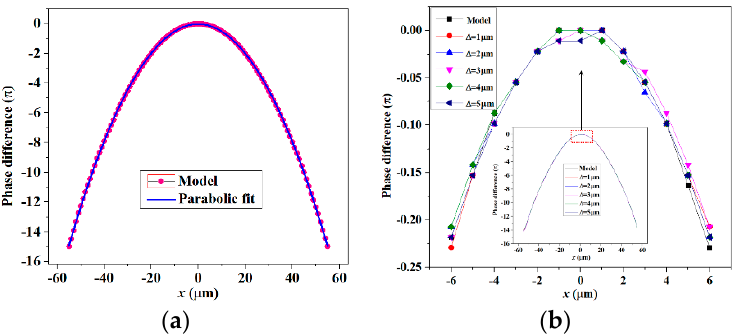
Figure 6. Simulated relative phase profiles of the LC microlens array ( a ) in an ideal alignment condition and ( b ) under different misalignment conditions at V on = 4.8 V rms .